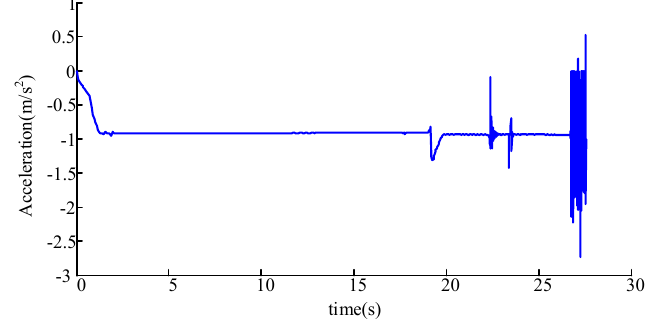
Figure 10. Vehicle speed and wheel linear speed.